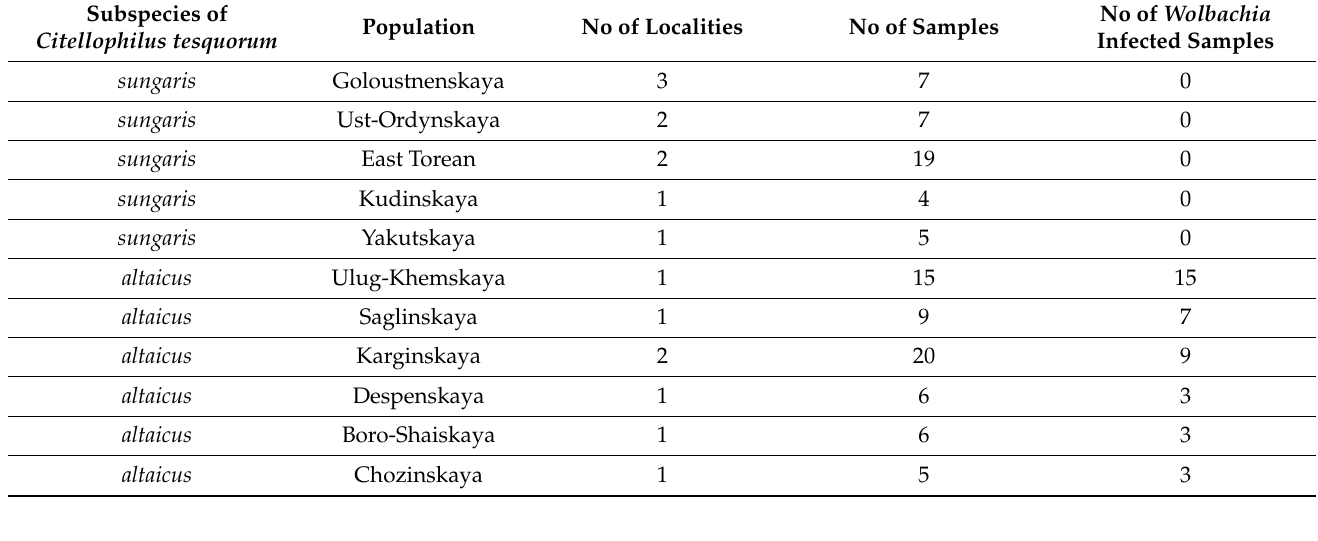
Table 1. Characteristics of data collection and Wolbachia infection.